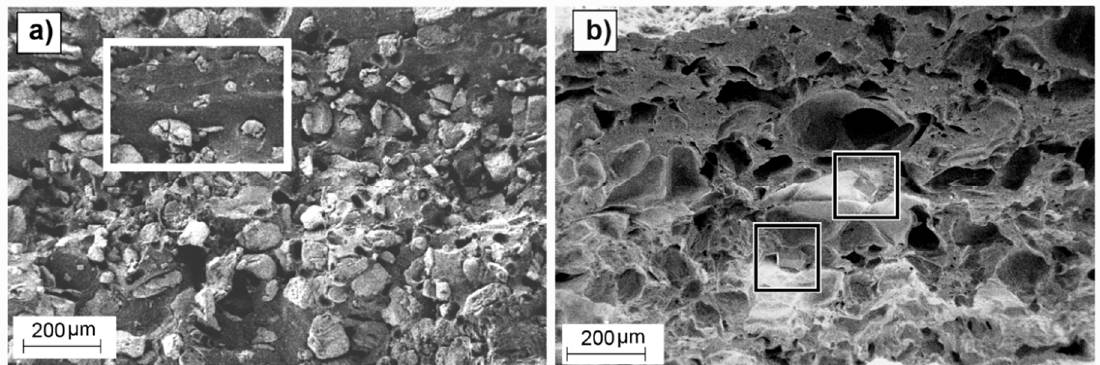
Figure 6. SEM images of cross-section surfaces of 501050 non-leached samples ( a ) and leached samples ( b ) showing non-porous polymer regions (outlined by a white rectangle in ( a )) and remaining salt particles (outlined by squares in ( b )).